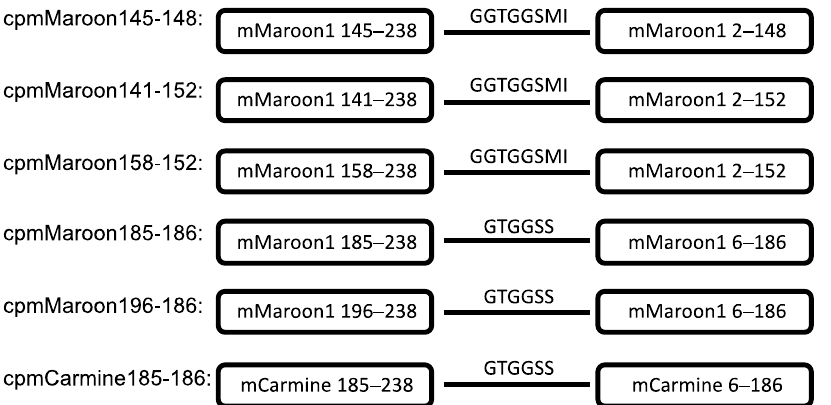
Figure 2. Primary structures of circularly permuted mMaroon1 and mCarmine variants. The portion in the circled bars represents the primary sequence of mMaroon1 or mCarmine. The original N- and C-termini are linked by an eight-residue “GGTGGSMI” linker or a six-residue “GTGGSS” linker.